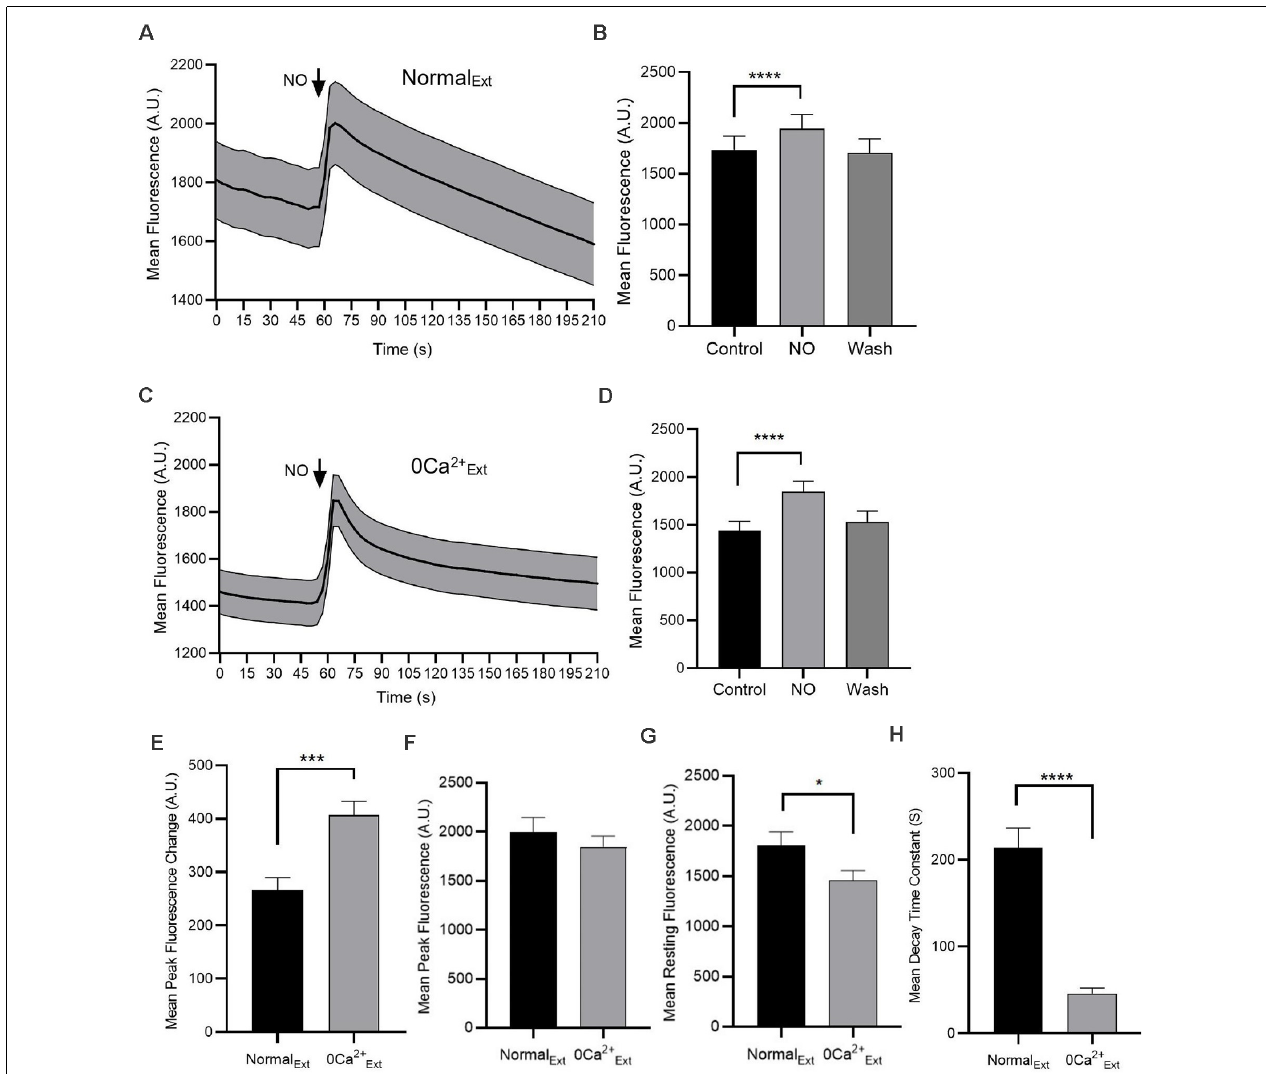
FIGURE 1 | NO increases cytosolic Ca 2+ concentration. Fluorescence intensity measurements from ACs loaded with Oregon Green BAPTA-1 488-AM are shown (A,C) . (A) In the normal external solution, NO produces an increase in cytosolic Ca 2+ . (B) The quantified mean fluorescence ± SEM; n = 45. ∗∗∗∗ P < 0.0001 (paired t -test). (C) In the absence of Ca 2+ (0 Ca 2+ Ext ), NO increases cytosolic Ca 2+ . (D) The quantified mean fluorescence ± SEM; n = 54. ∗∗∗∗ P < 0.0001 (paired t -test). (E) The quantified mean peak fluorescence ± SEM after subtracting baseline in normal external condition, n = 45 and in zero Ca 2+ external condition, n =